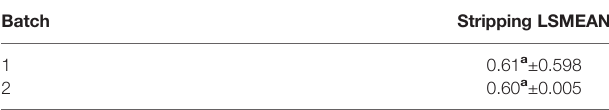
TABLE 3 | Least Squares Means of stripping percentage for batch 1and 2.